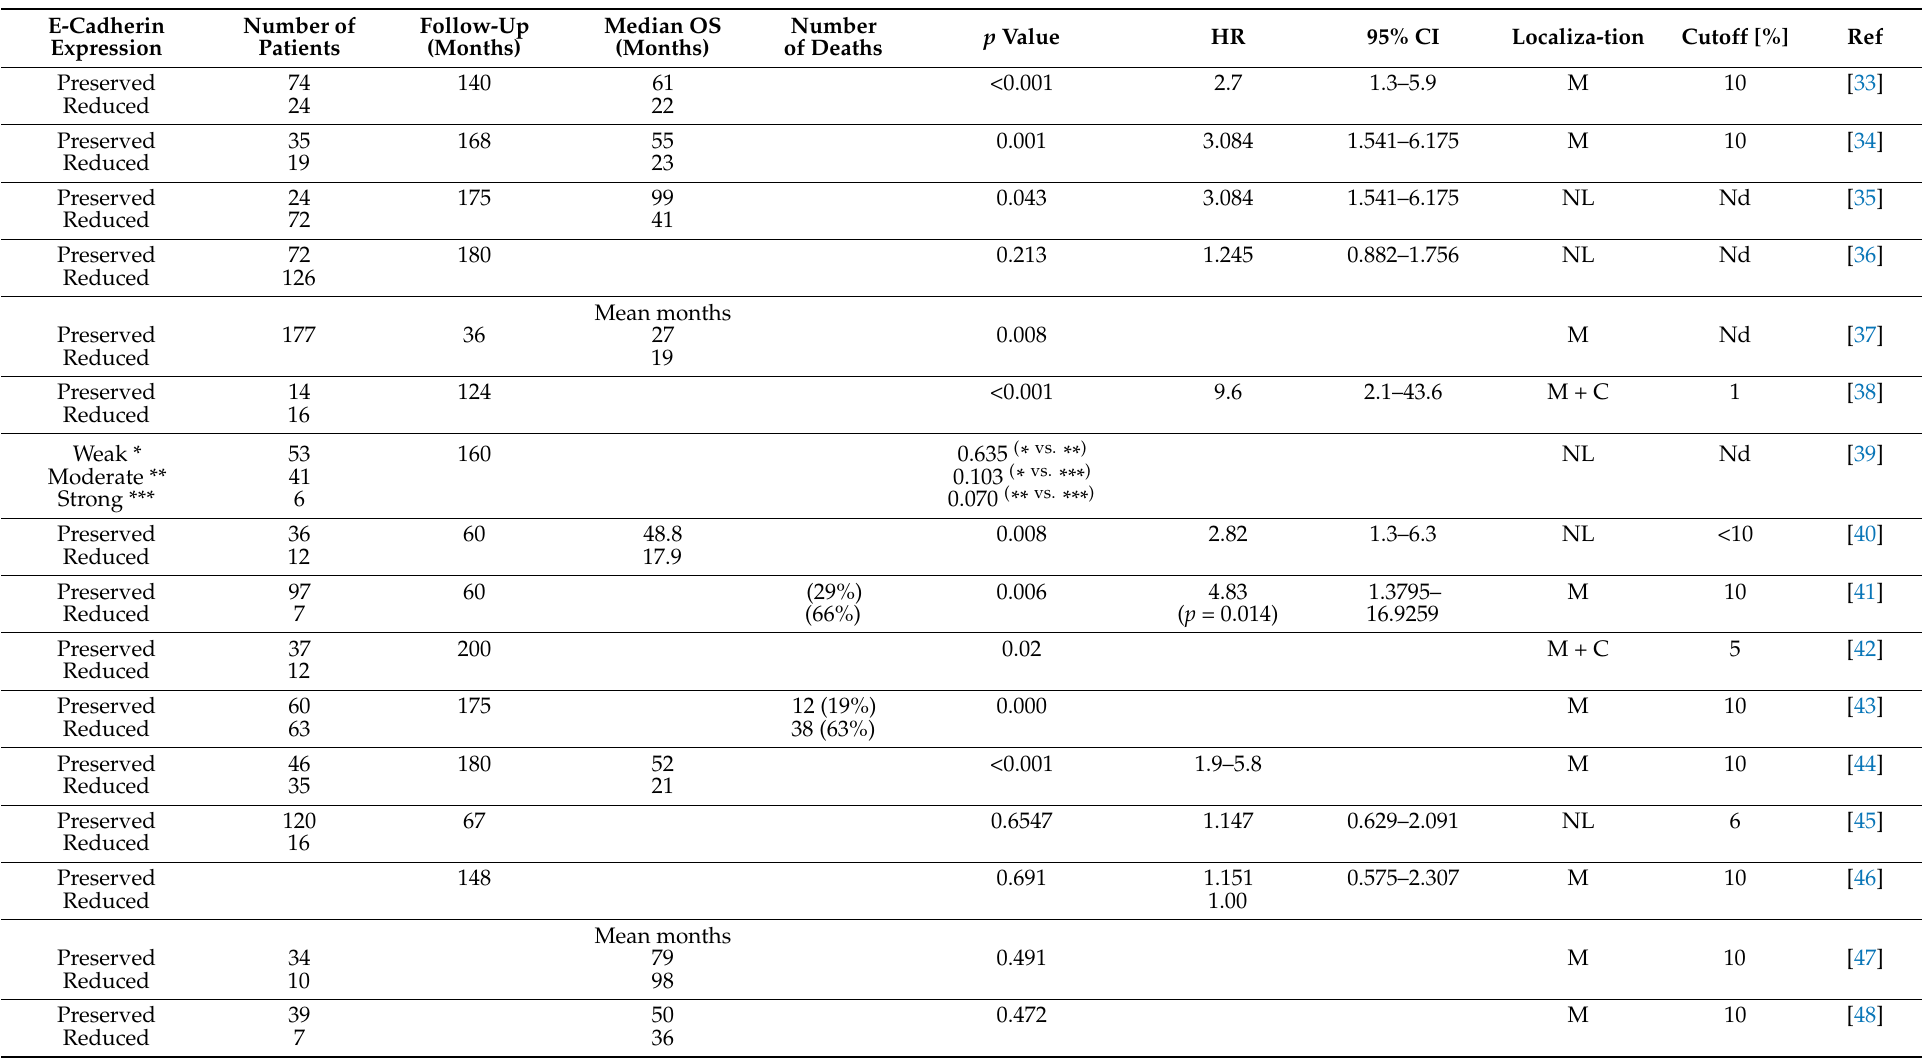
Table 1. The association of E-cadherin expression with the OS and PFS of EOC